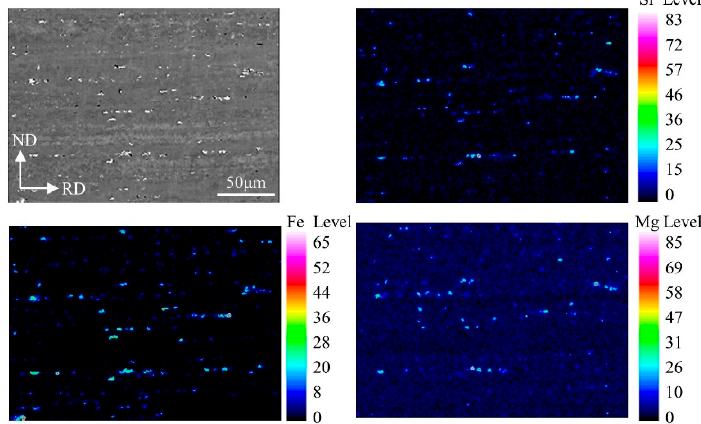
Figure 11. SEM image of alloy element distribution in VCR sample.